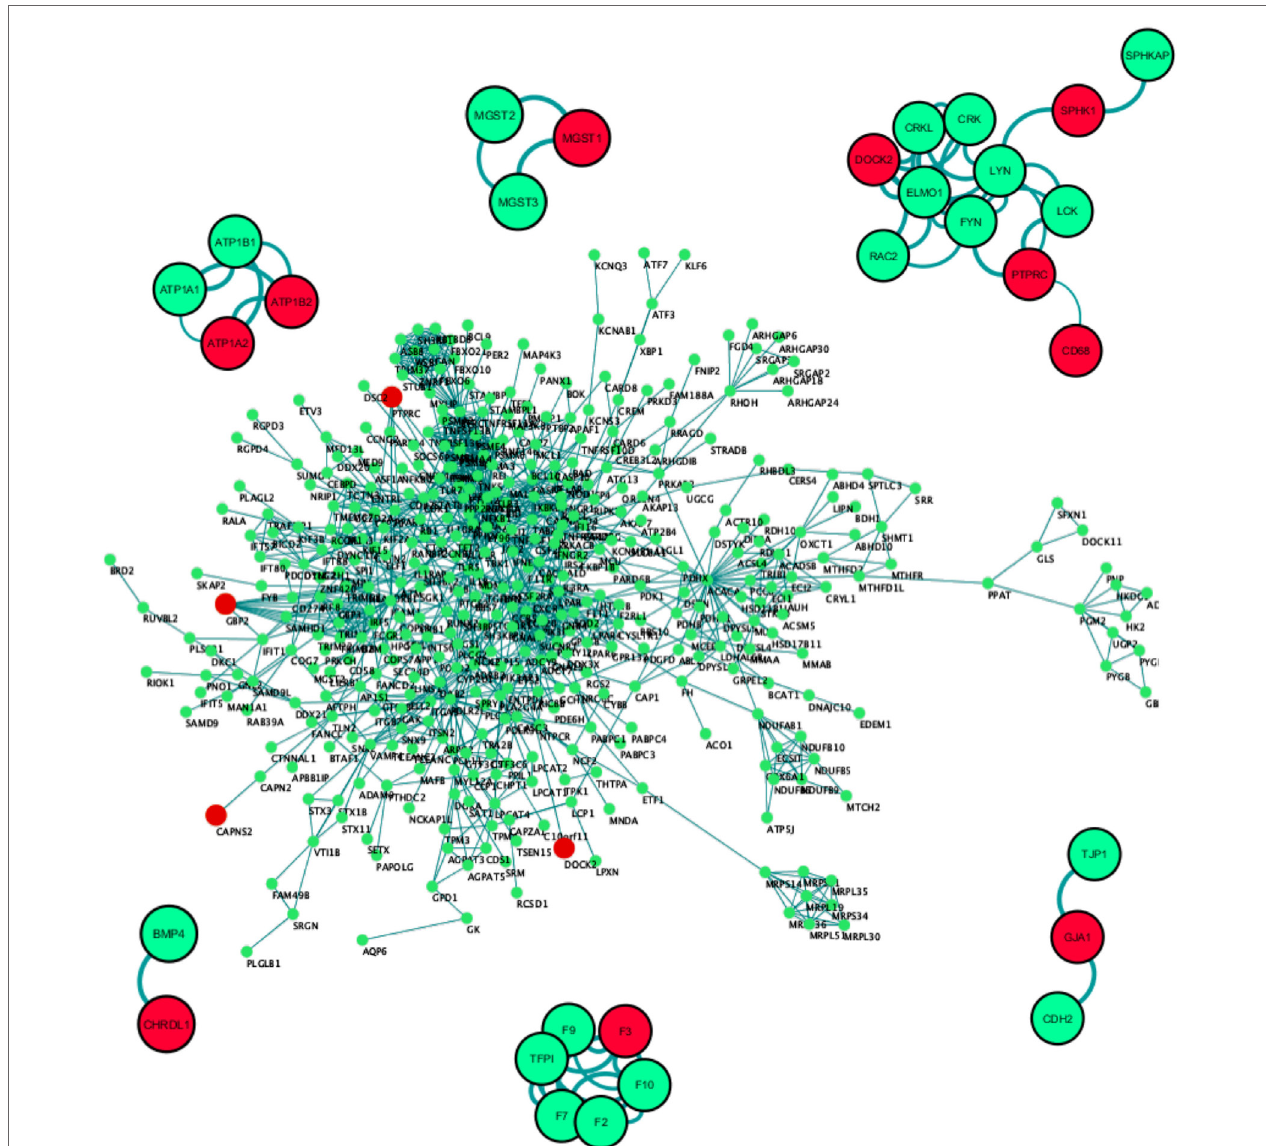
FigUre 4 | PPI network construction of dysregulated proteome coded by 3,290 genes. Only 994 out of 3,290 genes passed the threshold interaction score of 0.70. The second representative protein–protein interaction network of the top differentially expressed gene set (27 genes) showed 11 out of 27 proteins coded by differential expressed genes to be actively interacting with each other or with varied protein partners. Red: differentially expressed gene in the primary data set, green: interacting partner, edge indicates the source to target node strength. Combined interaction score > 0.70, No. of first level interactors =